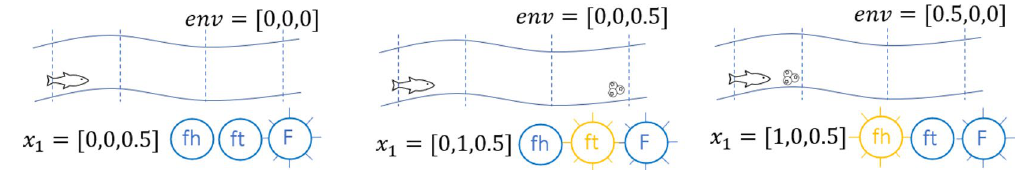
Figure 1. Robot Fish setting. The fish is half full/hungry, F = 0.5 . Left: no food. Middle: food on env 3 , thus